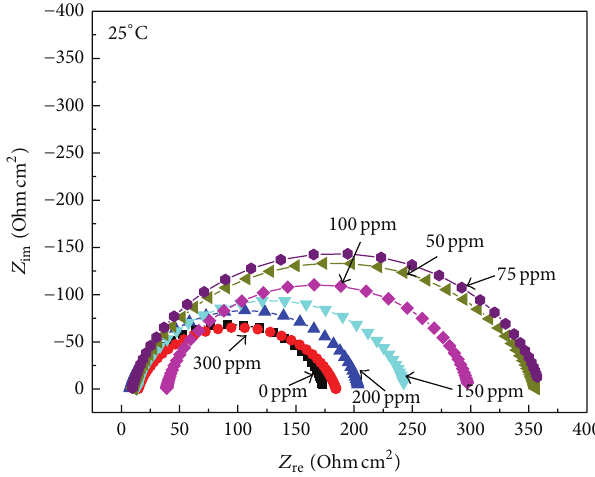
Figure 7: Effect of Opuntia ficus-indica concentration on the Nyquist diagrams for carbon steel in 1M HCl at 40 ∘